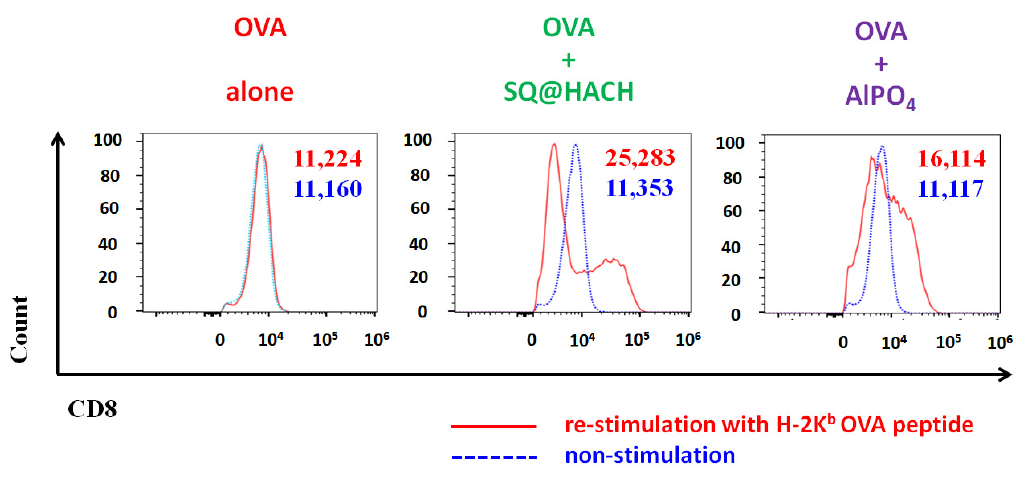
Figure 7. Activation of antigen-specific cytotoxic T lymphocytes. The splenocytes from immunized mice were obtained on day 14 after vaccination. Flow cytometric histograms and mean fluorescence intensity of CD8+ T cells were shown as re-stimulation for 24 h with H-2K b OVA peptide (OVA 257–264 , SIINFEKL) (red) or with medium only (blue), respectively.